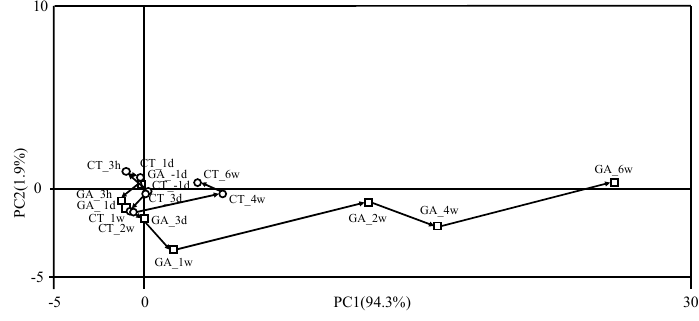
Figure 7. Principal component analysis of all samples for 18 DEGs, including the MADS-box genes listed in Table 2; expression patterns were described in Figure 7. Open circles indicate GA-nontreated control samples. Open squares indicate GA-treated samples.